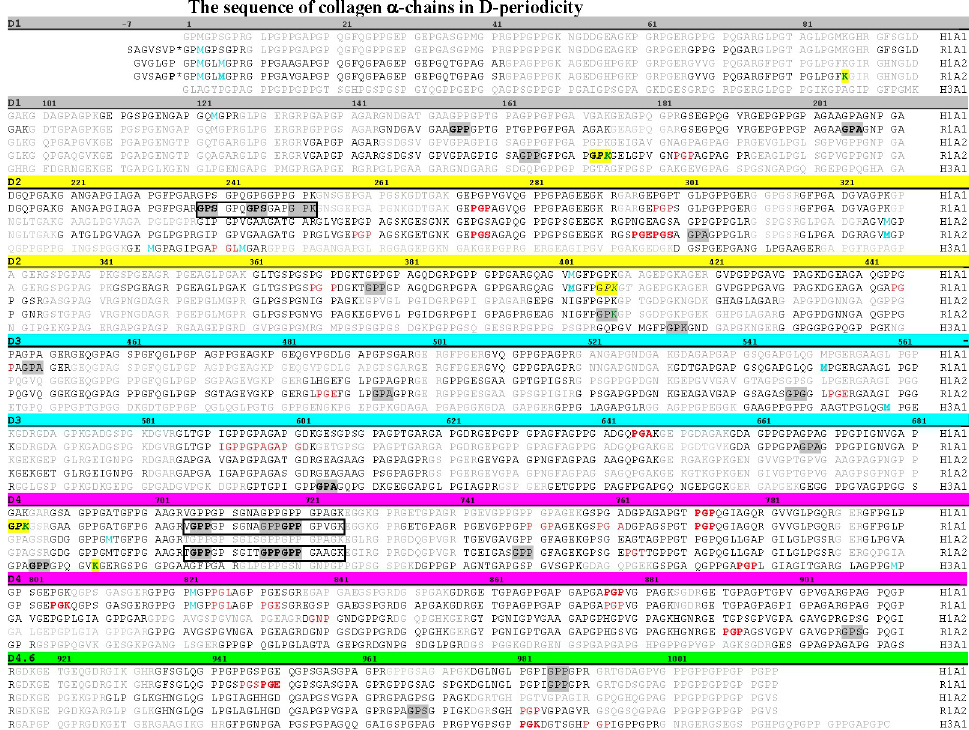
Fig 3. The mapping of individual unexpected hydroxylation sites on the α chains of collagen. Sequences of the α 1 (I) and α 2 (I) chains of human (H1A1 and H1A2, respectively), the α 1 (I) and the α 2 (I) chains of rat (R1A1 and R1A2, respectively), and the α 1(III) chain of human (H3A1) were arranged by the D -periodicity according to Di Lullo et al [54]: the 4 D -periods are highlighted by a colored bar of grey, yellow, cyan, and magenta, respectively; the 0.6 D is marked by the colored bar of green. The Gly-X-Y triplets including an O x are in grey highlight. The P y residues in the tripeptide unit of Y-Gly-X are shown in red in order to reflect the potential connection with the enzyme selectivity of C-P4H (see text). The entire segment of the three highly variable regions (N- or C-HVR, see text) with multiple O x residues are boxed. The hydroxylated proline in the telopeptide is P � . Hydroxylysines and the Gly-Pro-Lys tripeptide where the hydroxylation could not be precisely located between the Pro-Lys residues at the C-terminus of a peptide (see text) are highlighted in yellow with Lys in green font. The oxidized methionines are in blue colored font. In all cases the PTMs observed from more than one detection/sample preparation were shown in bold font. Not sequenced regions are in faint grey. The amino acid sequence of the five collagen α chains were adapted from the UniProt